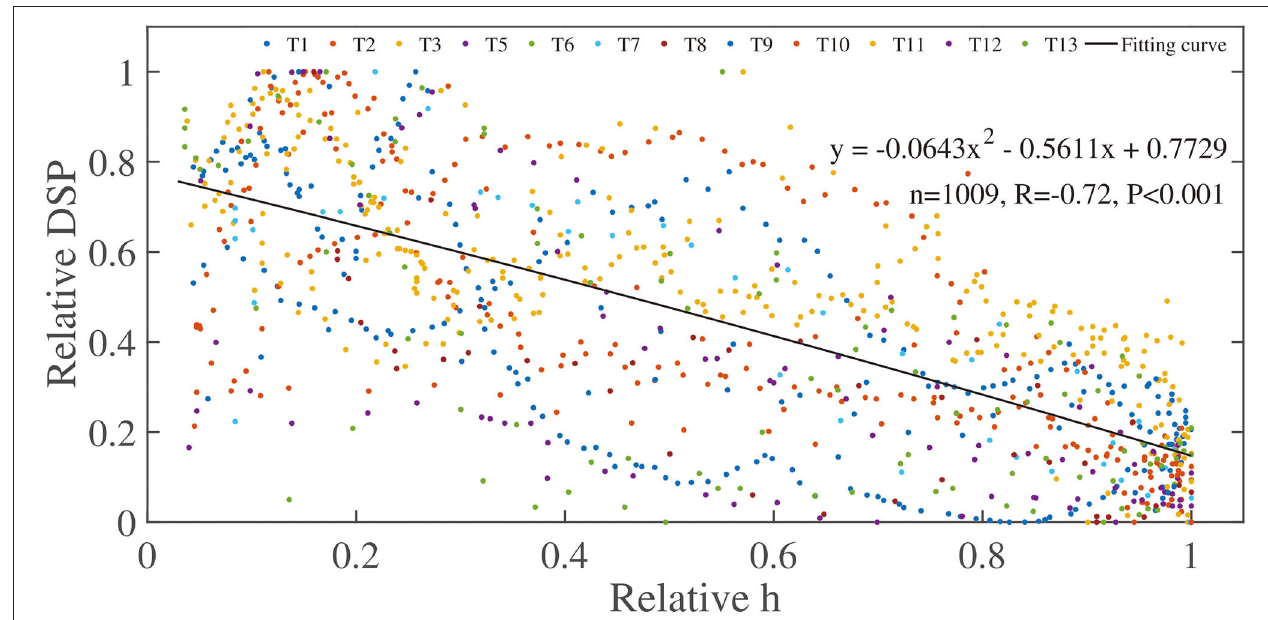
FIGURE 7 | The distribution of the relative DSP against the relative h from all tidal cycles, except T4 where wave climate was enhanced